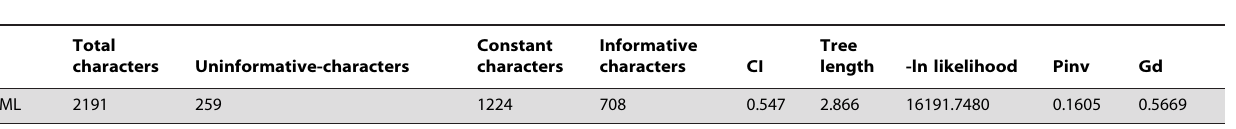
Table 3. Tree statistics for rDNA data